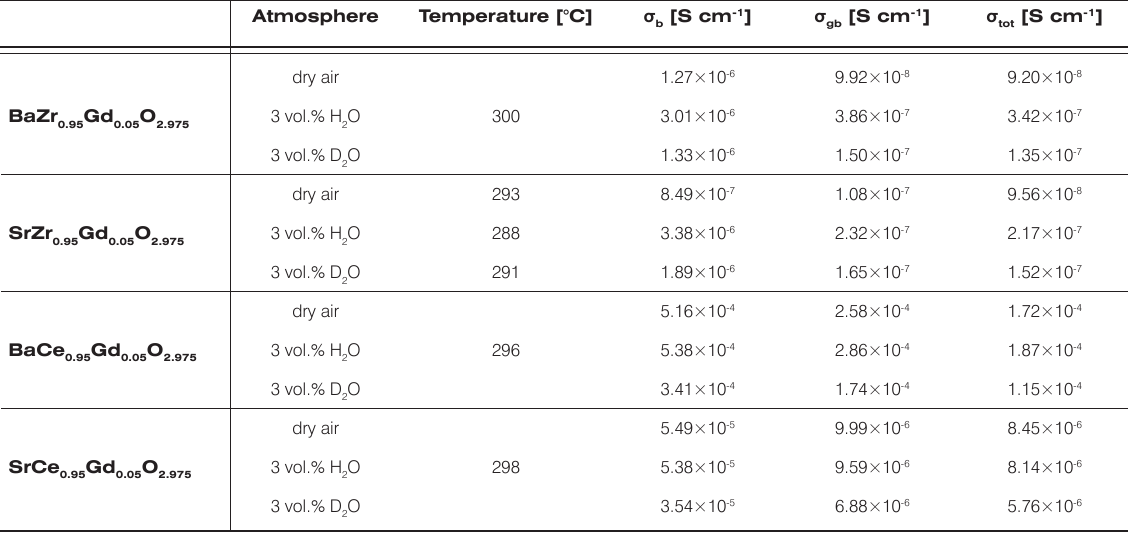
Table 3. Bulk, grain boundary and total electrical conductivity of proton